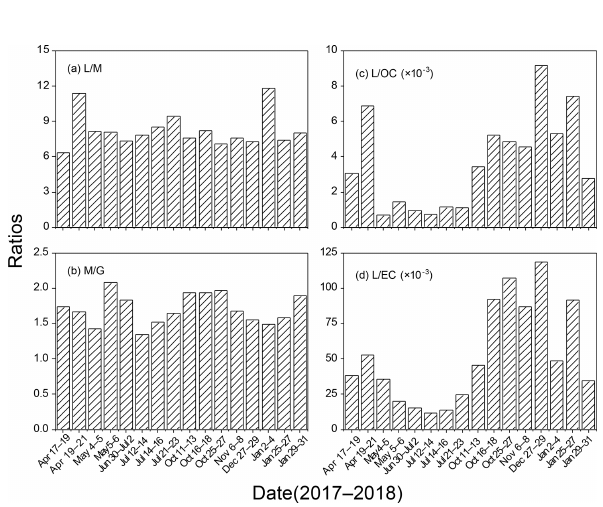
Figure 2. Temporal variations in the concentration ratios of L / M (levoglucosan to mannosan), M / G (mannosan to galactosan), L / OC (levoglucosan to organic carbon) and L / EC (levoglucosan to ele- mental carbon) for urban aerosols in